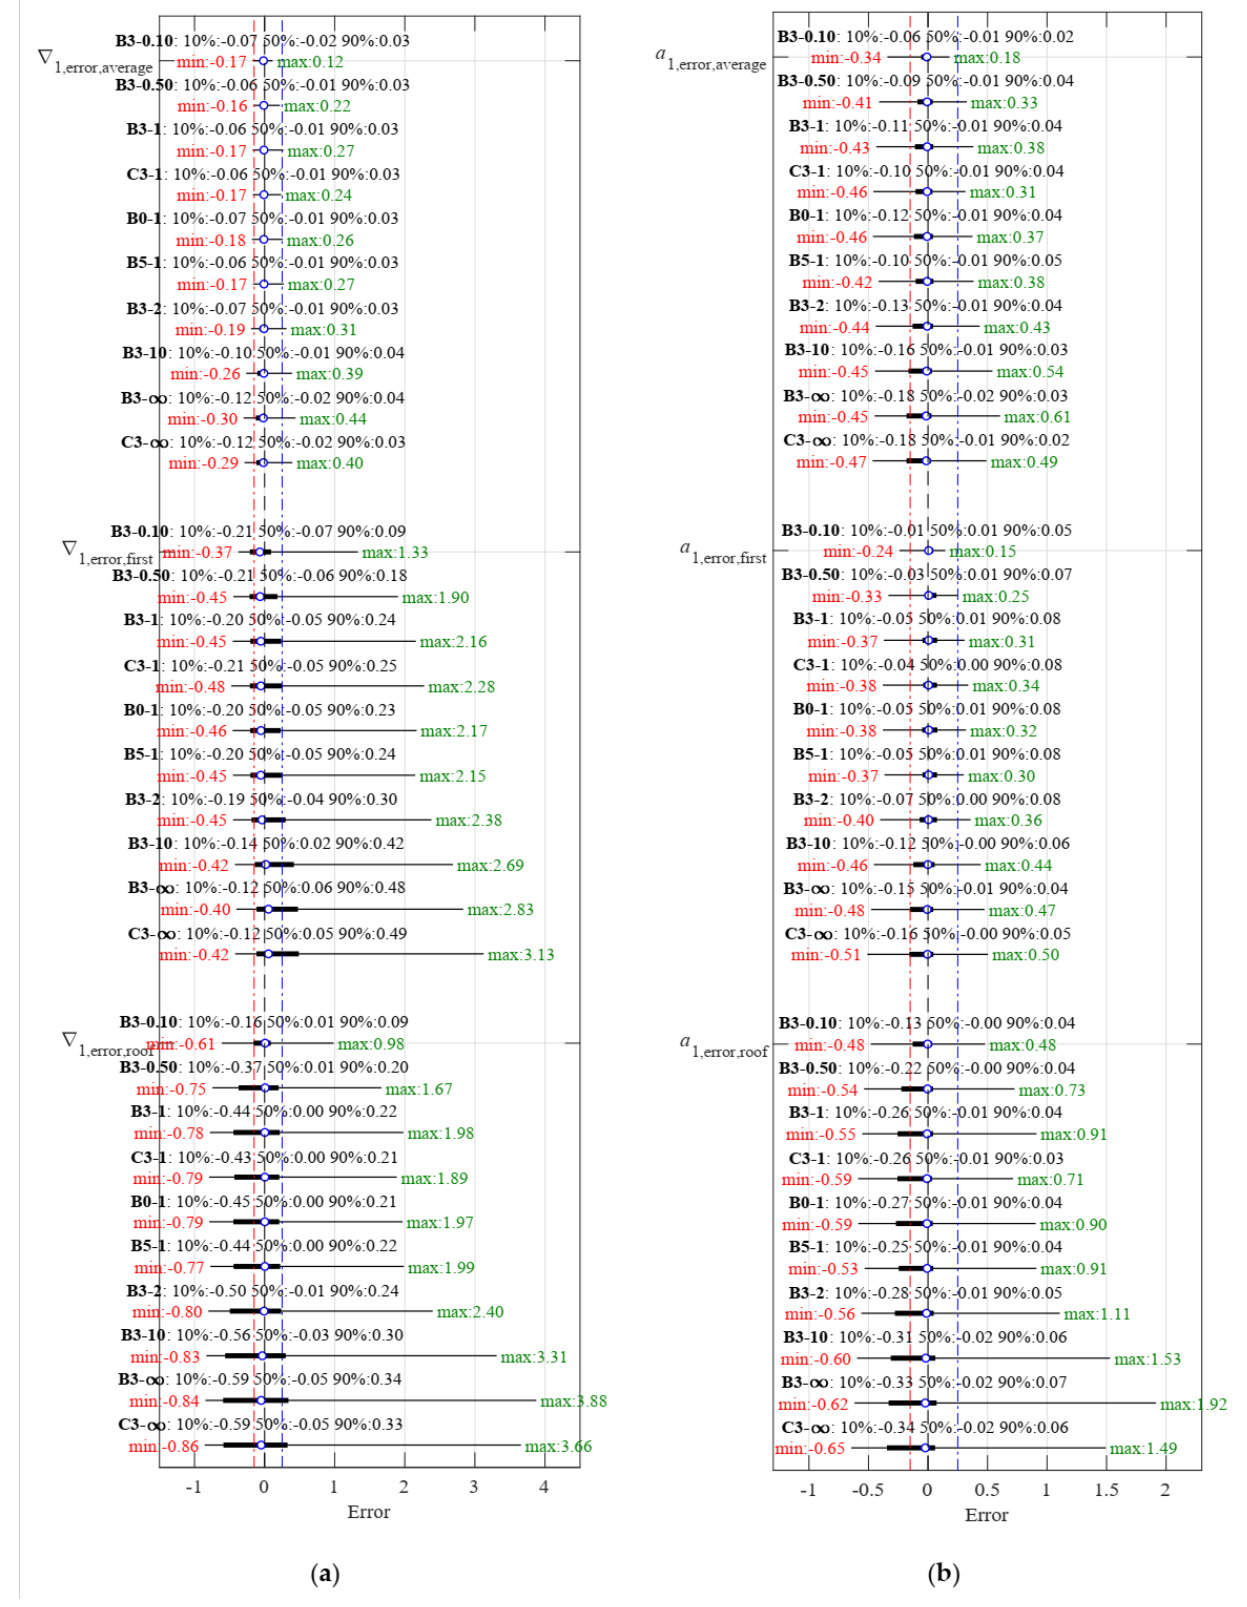
Figure A4. Bar plot for error type 1, average of stories, first story and roof: ( a ) inter-story drift velocity ∇ error,1 ; ( b ) absolute acceleration a error,1